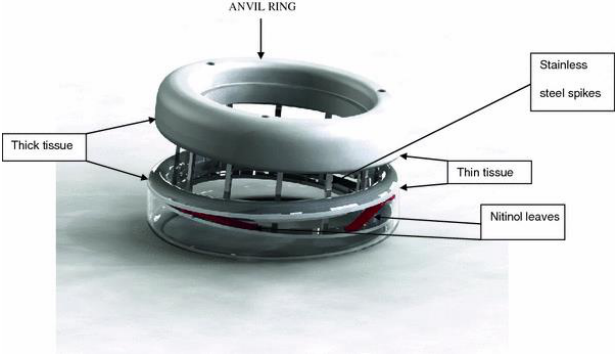
Figure 3. Illustration of the endoluminal compression anastomotic ring (EndoCAR), reprinted with permission from Springer [42].